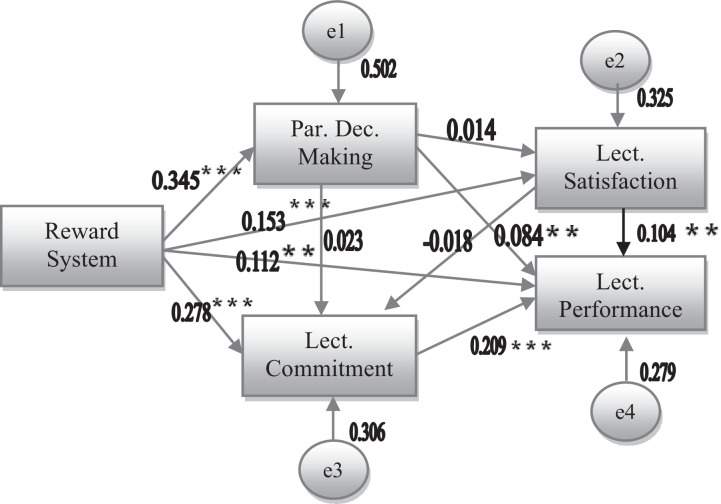
Original Model on Lecturer Performanceχ2 = 187.108; p  = 0.000; GFI  =  0.793; AGFI  =  0.690; RMSEA  =  0.226*= p  <  0.10; **= p  <  0.050; ***= p  <  0.001